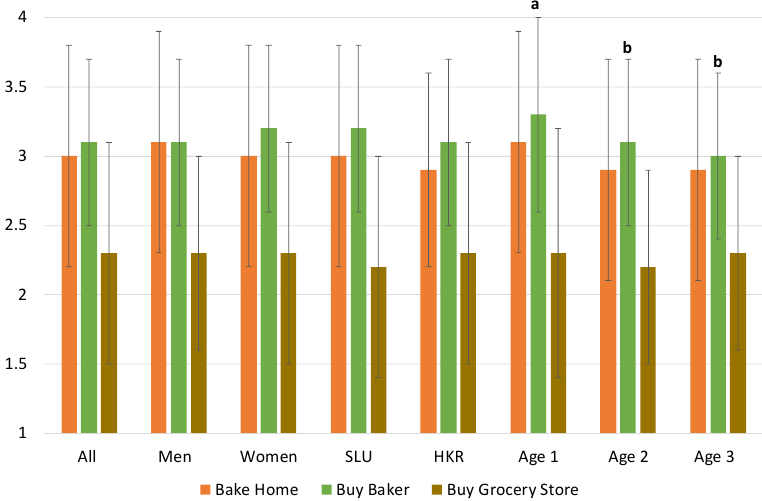
Figure 4. Mean and standard deviations showing trends of purchasing at di ff erent sites. Significant di ff erences are indicated with di ff erent letters. The scale was 1–4, where 1 = always, and 4 = never. Factors that govern consumers’ preferences for products based on heritage cereals are presented in Table